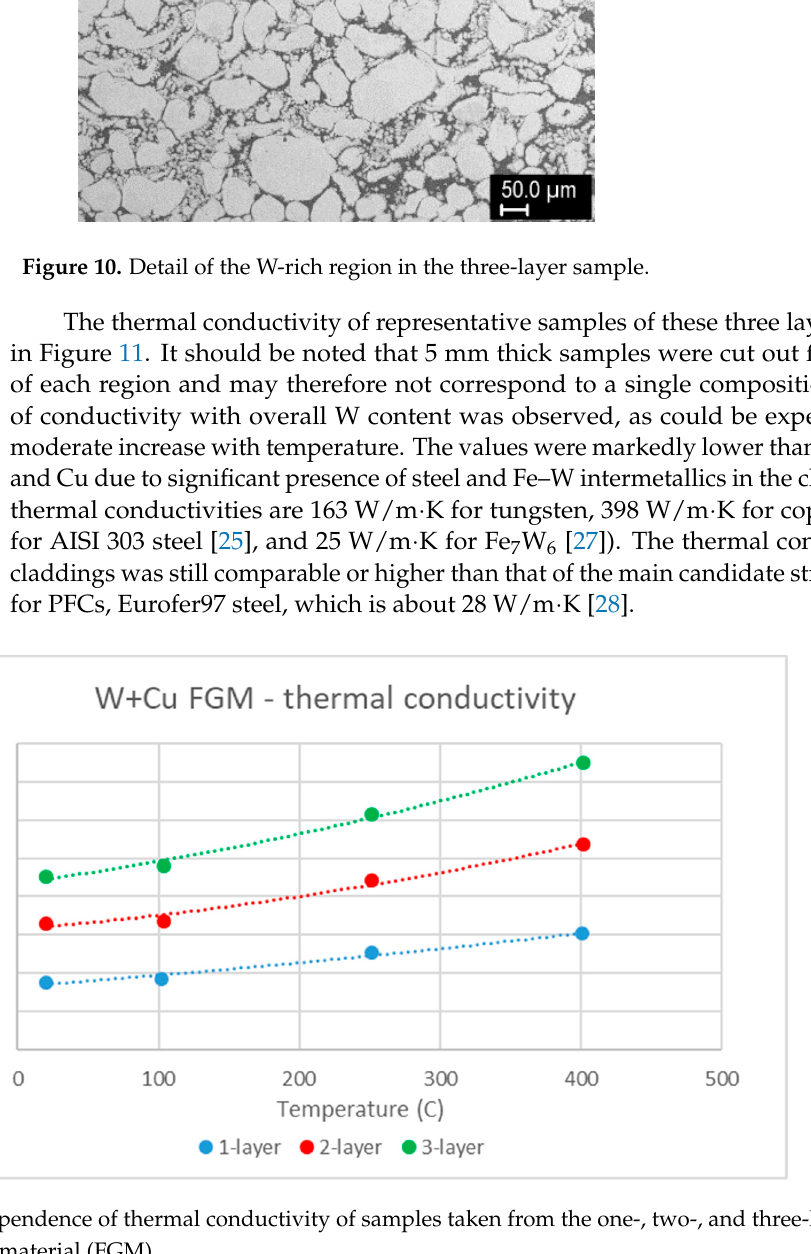
Figure 9. Cross sections of three-layer W–Cu cladding on a steel substrate: ( a ) one-layer (75% W), ( b ) two-layer (75% + 95% W), ( c ) three-layer (75% + 95% + 98% W).